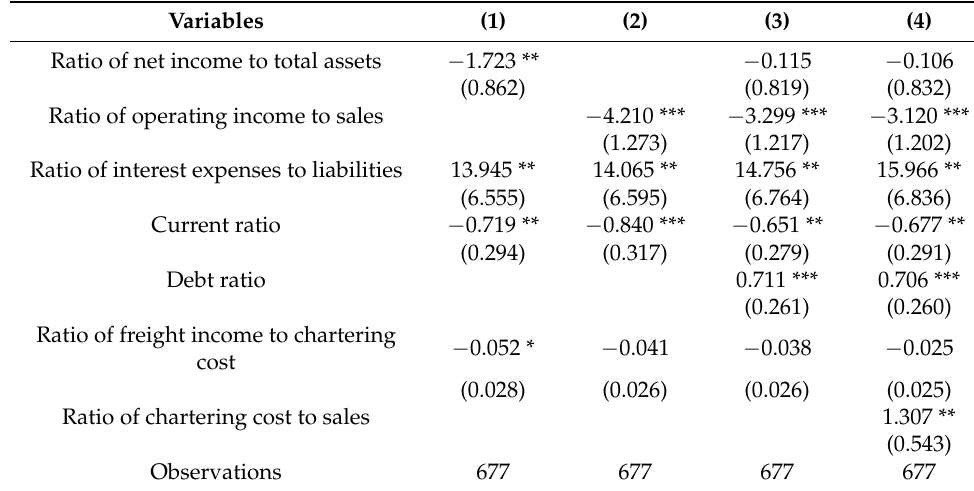
Table 7. Logit model estimation results.